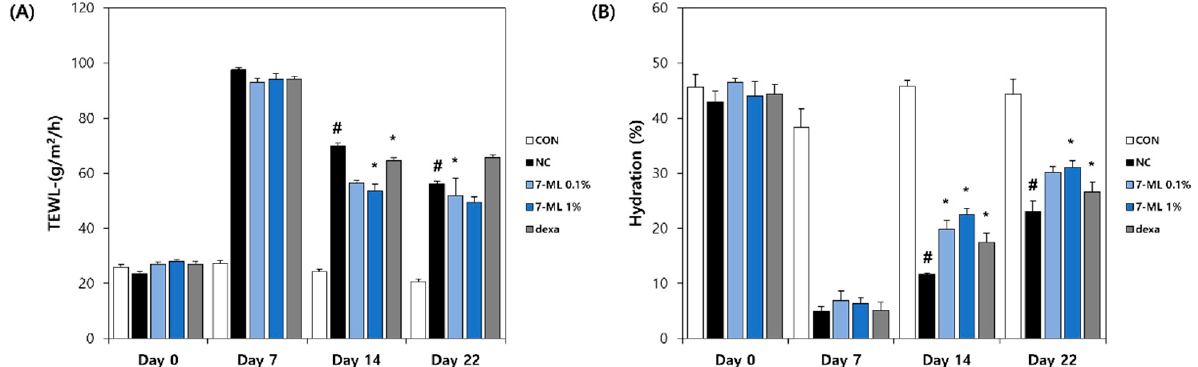
Figure 7. Effects of 7-ML on skin barrier function in a DNCB-induced mouse model. The level of TEWL ( A ) and the level of skin hydration ( B ) were measured using a Tewameter TM210 and Skin-O-Mat for 3 weeks. The results are expressed as a mean ± SD ( n = 3). # p < 0.05 vs. nontreated control; * p < 0.05 vs. the DNCB-treated negative control. CON, nontreated control; NC, DNCB-treated negative control; 0.1% or 1% 7-ML, DNCB + 0.1% or 1% 7-ML-treated groups; dexa, DNCB + dexamethasone-treated